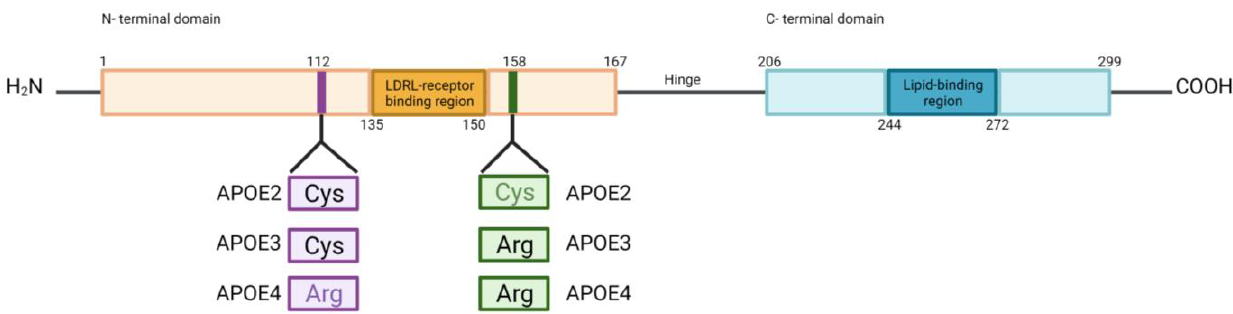
Figure 3. Amino acid residue substitutions of APOE isoforms. APOE consists of an N-terminal domain that contains an LDLR receptor-binding region connected by a hinge region with a C-terminal domain that contains a lipid-binding region. Positions 112 and 158 show amino acid substitutions among APOE isoforms. Cysteine (Cys). Arginine (Arg). Created with BioRender (BioRender.com).